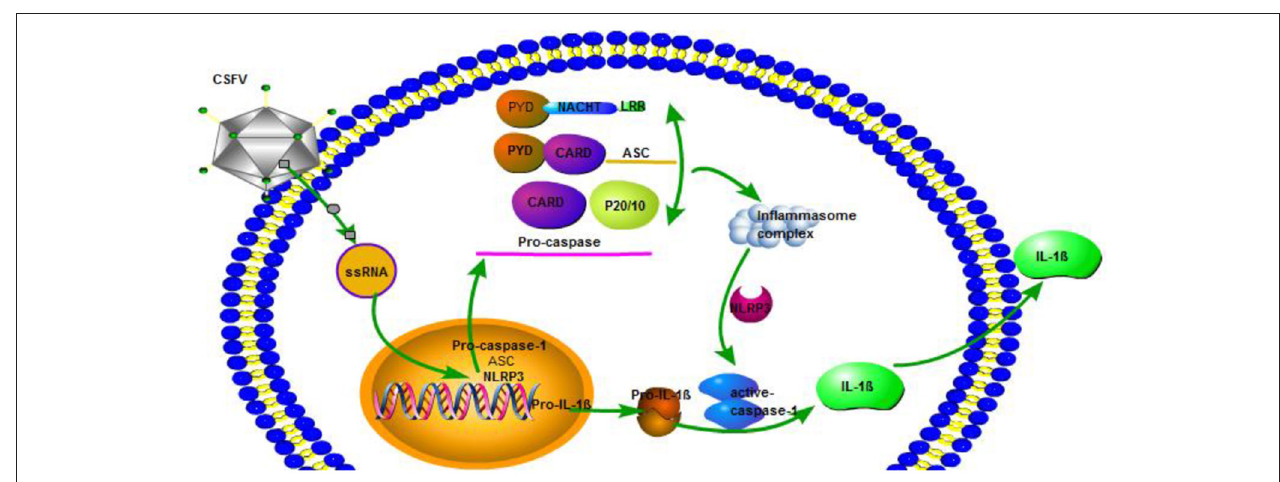
FIGURE 9 | CSFV activation of interleukin-1 β release is dependent on NLRP3. CSFV infection activates caspase-1, induces the formation of inflammatory complexes ASC, and activates caspase-1 through pro-IL-1 β and NLRP3 to promote the release of IL-1 β .